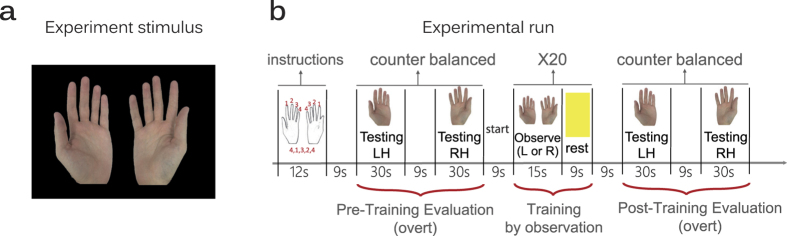
Experimental design.(a) Subjects learned a novel sequence of finger movements by observing two virtual hands while one of the hands performed the sequence. (b) Each subject completed two experimental runs. In each run, a unique sequence of five digits was presented together with a sketch of the mapped fingers. After instructions, subjects performed the sequence using their right hand (RH) and their left hand (LH) for initial evaluation of performance level. In the training stage subjects passively observed either the right or left virtual hand performing the sequence. After training, subjects repeated the evaluation stage for assessment of changes in performance level.